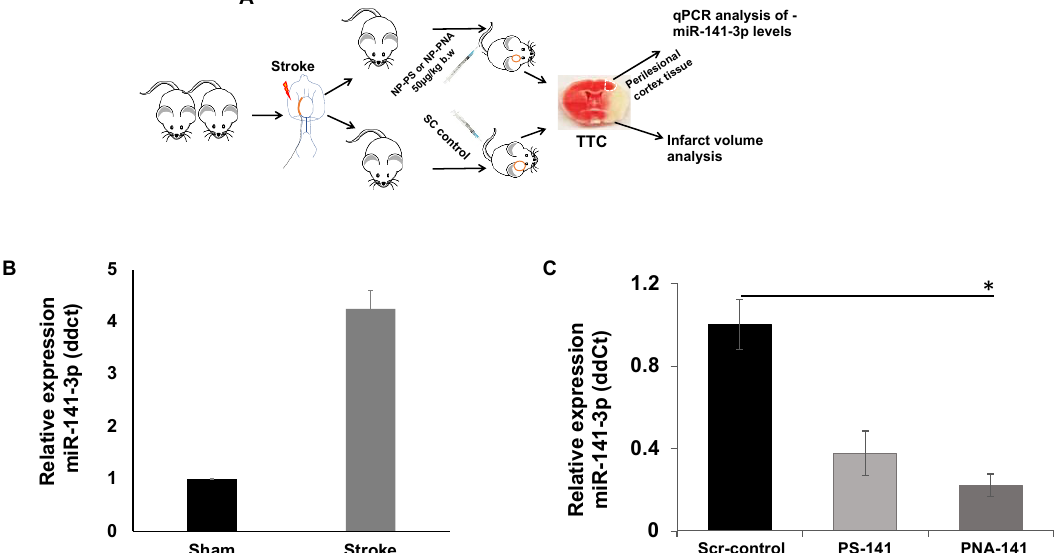
Figure 8. ( A ) Schematic showing in vivo work flow in mice after ischemic stroke. ( B ) Relative miR-141 gene expression analysis in RNA isolated from perilesional cortex of ischemic brain tissues and control (sham) samples (n = 3). ( C ) Relative miR-141 gene expression analysis in RNA isolated from perilesional cortex of ischemic brain tissues after systemic treatment with indicated nanoparticles on x-axis (n = 7, n = 7, and n = 8 in scrambled control, PS-NP and PNA-NP, respectively). PNA-141-3p NPs significantly (* p < 0.05 vs. Scr-NP) reduces miR-141-3p expression levels in brain tissue of socially isolated stroke mice. MiR-141-3p levels were optimally reduced by PS-141-3p NPs. Data are shown as mean ± standard error mean (SEM), Student T test was used for statistical analysis. * p <